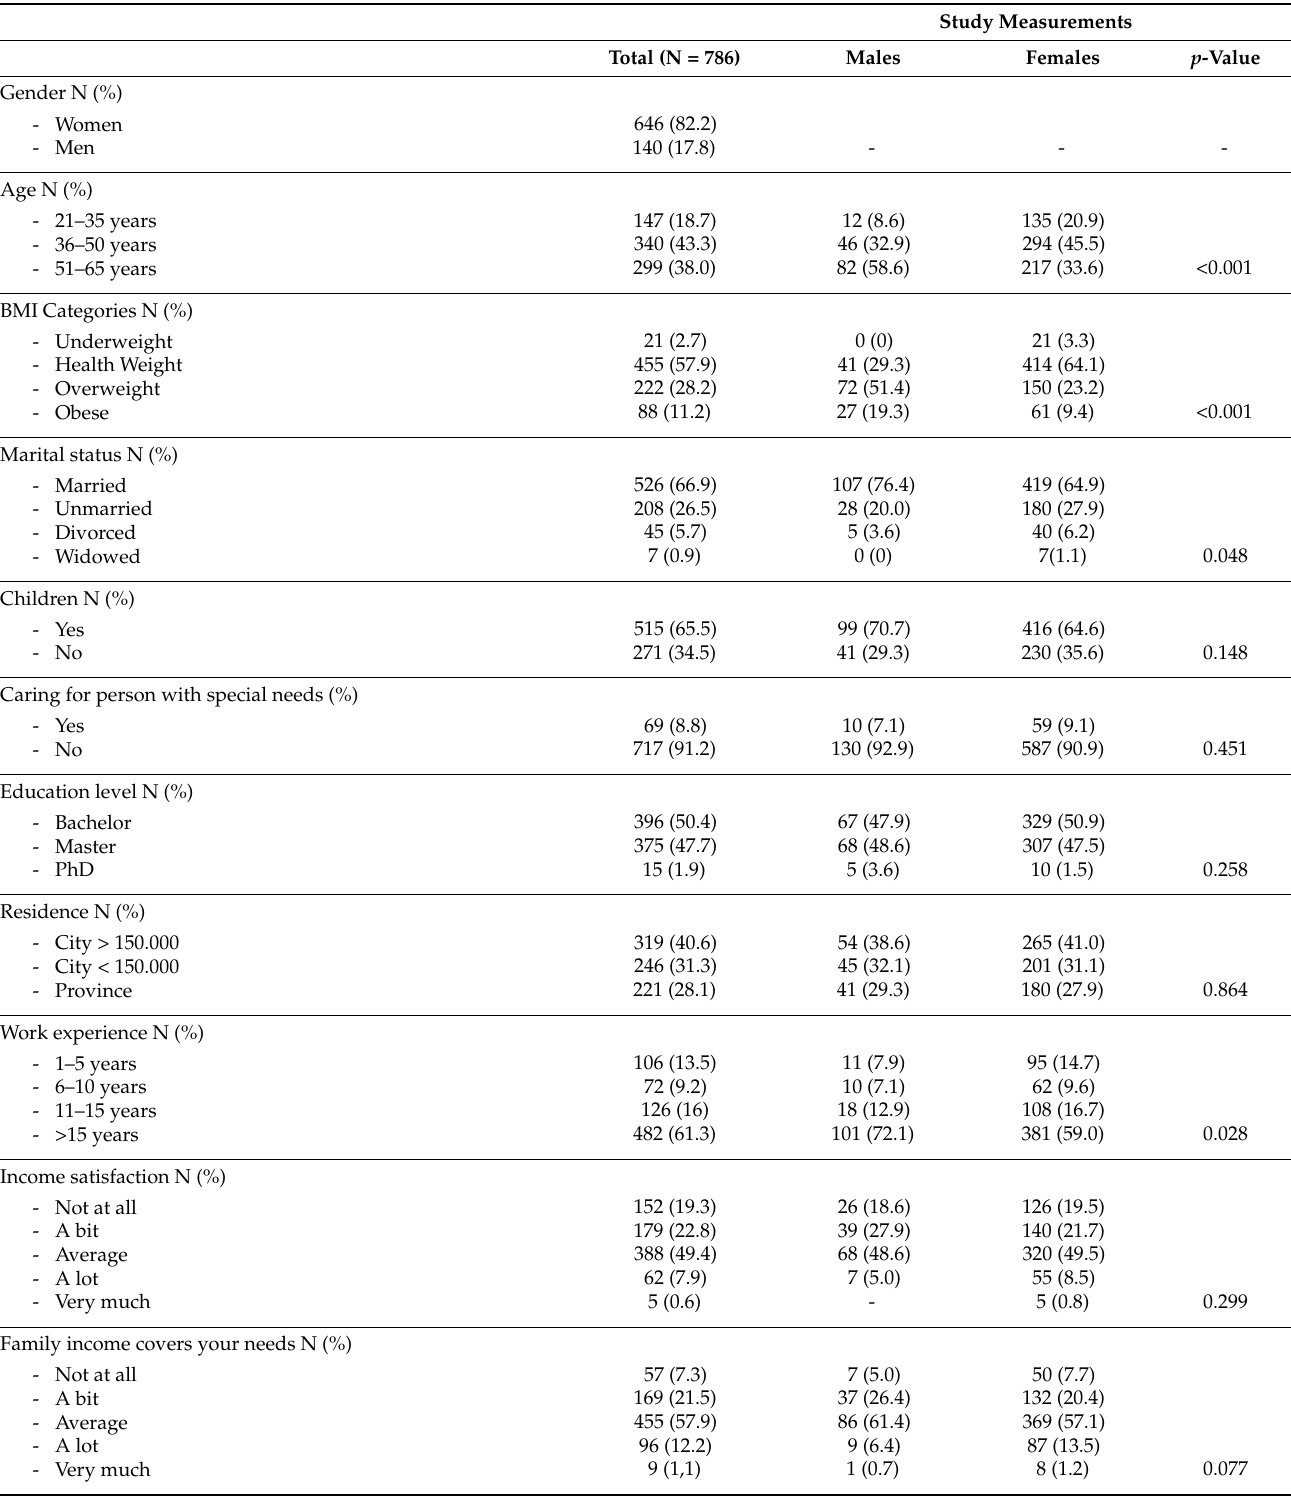
Table 1. The sample’s sociodemographic and lifestyle characteristics (N =